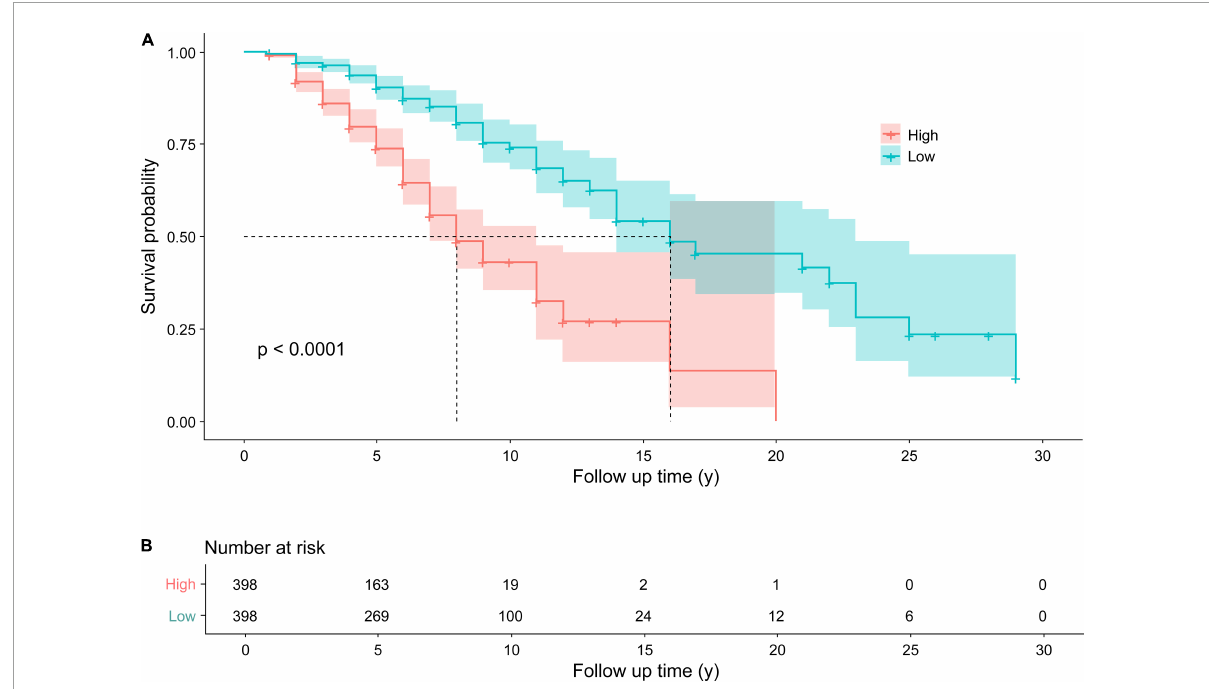
FIGURE2 Kaplan–Meier survival curves (A) for patients with PD with higher and lower risks of EDS. The Kaplan–Meier curves showed a significant difference over time between patients with Parkinson’s disease with a higher risk of EDS and those with a lower risk of EDS. Follow up time (y): the time from the diagnosis of PD to the end of follow-up, namely, the course of disease at baseline plus 1 year. Number at risk (B) the Number of EDS in patients with PD in the high and low risk groups, respectively. PD, Parkinson’s disease; EDS, excessive daytime sleepiness.